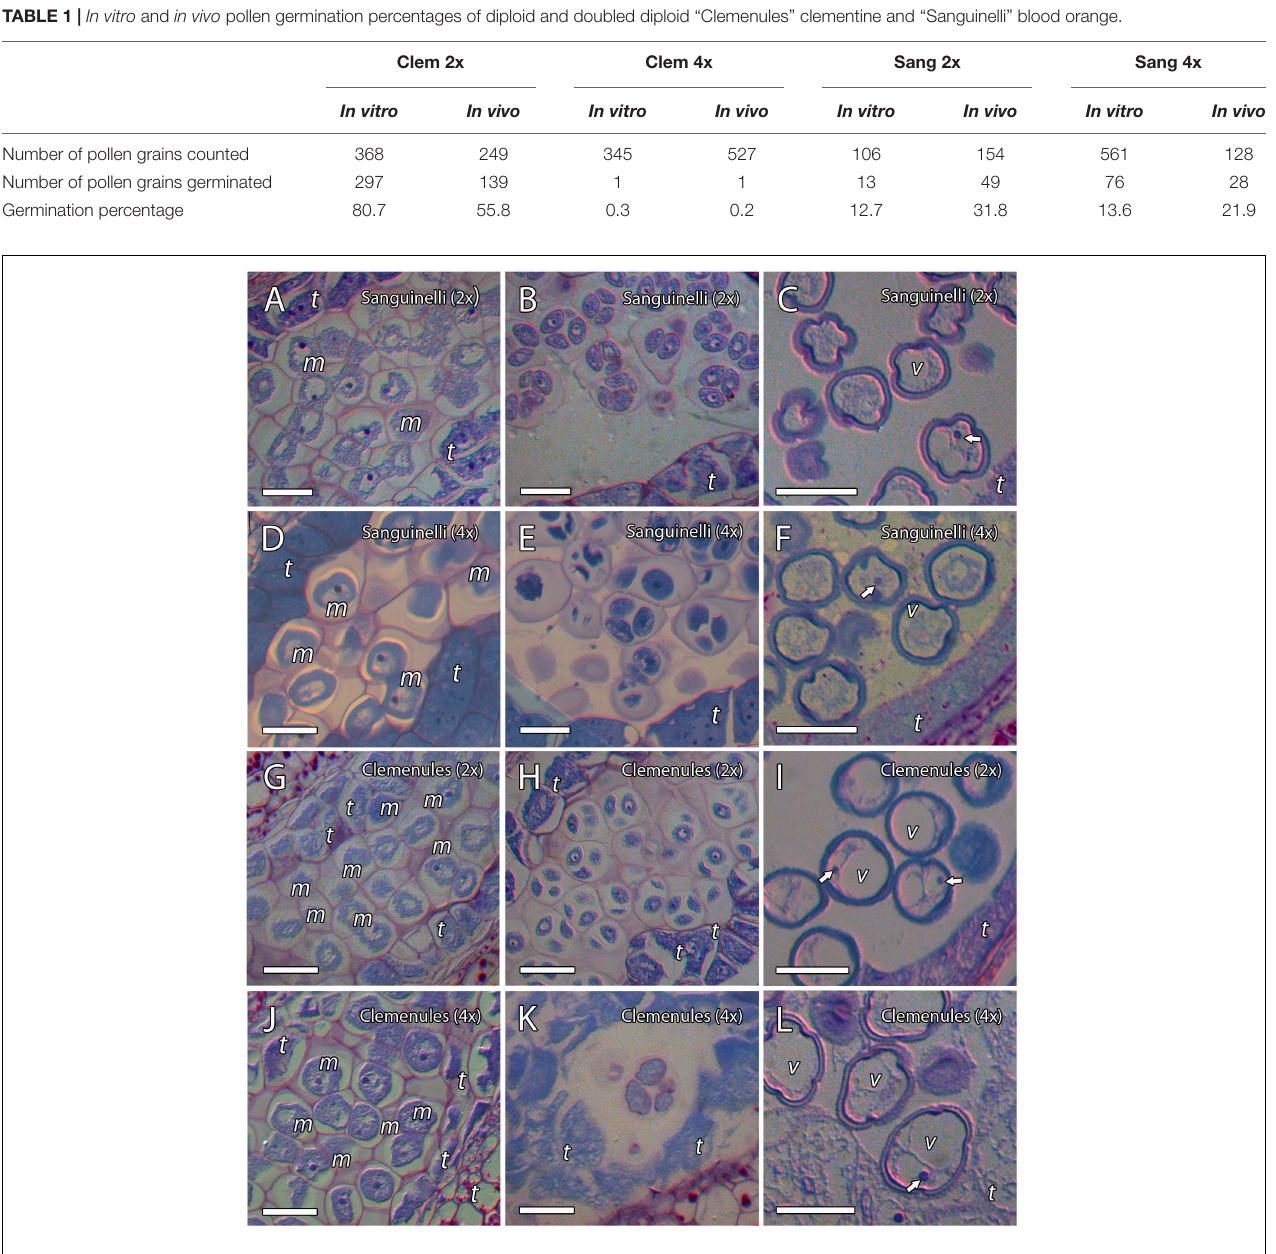
FIGURE 2 | Microsporogenesis of diploid and doubled diploid “Sanguinelli” blood orange and “Clemenules” clementine. Sections were stained with periodic acid-Schiff reagent (PAS) and toluidine blue. (A,D,G,J) Microspore mother cells surrounded by the tapetum. (B,E,H,K) Microspores undergoing meiosis and cytokinesis. (C,F,I,L) Individualized microspores with cytoplasmic vacuolization and the nucleus displaced laterally (white arrows). All scale bars = 25 µ m. Tapetum (t), microspore mother cells (m), vacuole (v), diploid (2x), and doubled diploid